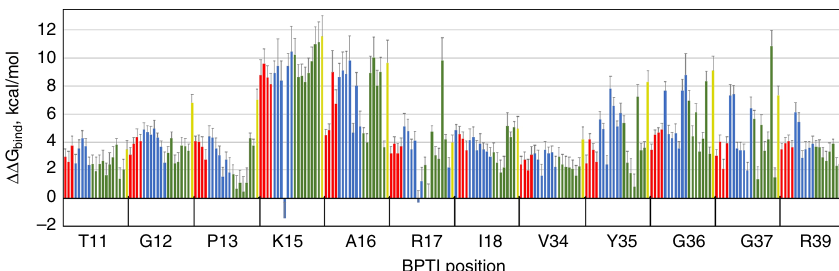
Fig. 4 Binding landscape of the BPTI/BT interaction. Changes in ΔΔ G bind for all single mutants of BPTI interacting with BT. Each bar represents a mutation to one amino acid including polar amino acids (red), hydrophobic amino acids (green), charged amino acids (blue) and Cys (yellow). X -axis shows WT residue followed by position on BPTI. 95% con fi dence interval for each ΔΔ G bind value is shown as calculated from the bootstrapping of the NGS data (see the “ Methods ” section). Source data are provided as a Source Data